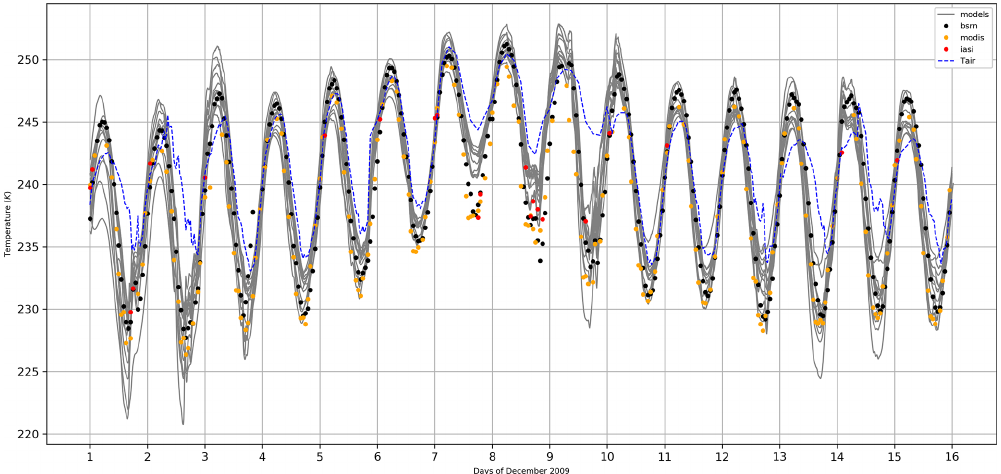
Figure 5. Temporal evolution of the surface temperature observed by BSRN (black dots), MODIS (orange dots), and IASI (red dots), simulated by the different models (gray lines), and of the air temperature (dashed blue line).